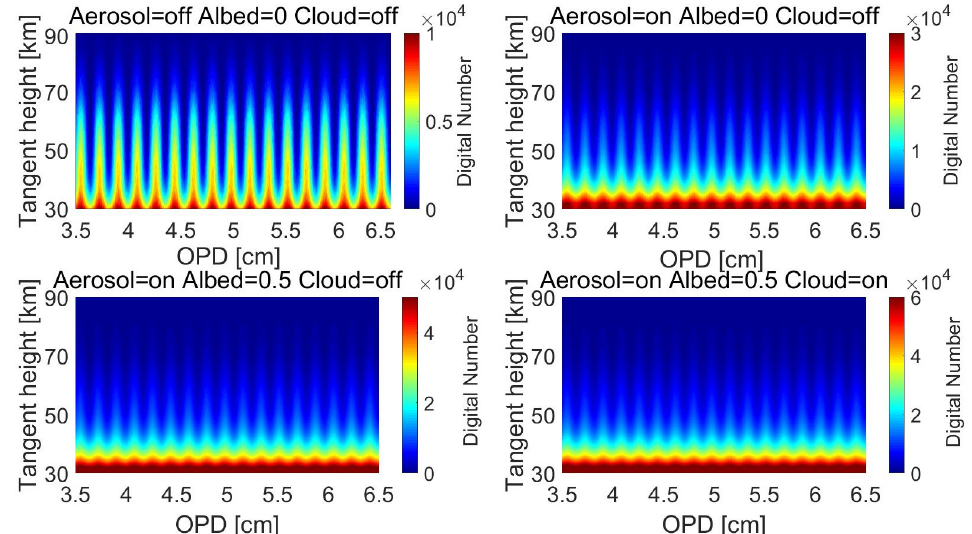
Figure 12. The variations of the combined signal images with aerosol, albedo, and cloud. The sensitivity functions for the simulated interferogram images were determined for each OPD (corresponding to points along the horizontal axis of the interferogram image). tions from all OPD values, assuming a constant tangent height along each row. Statistically